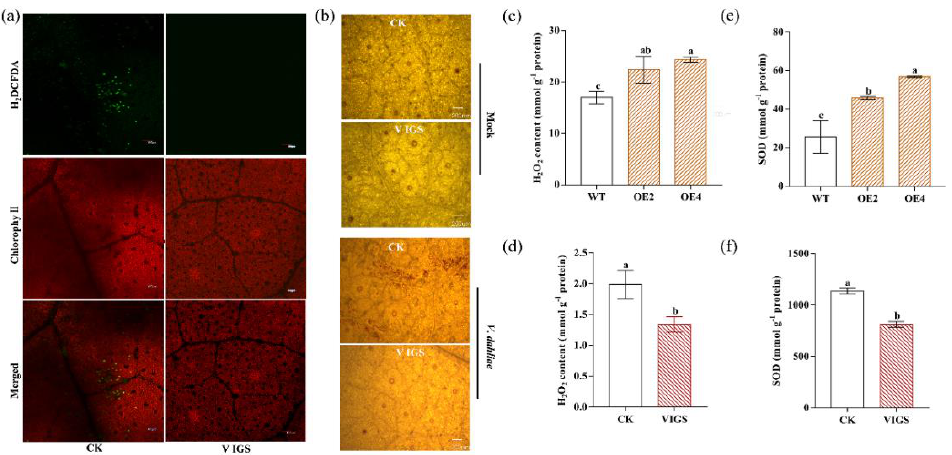
Figure 9. Determination of H 2 O 2 content and activities at 2 dpi. ( a ) Detection of ROS levels in cotton leaves by H 2 DCFDA staining. Then 10 mM H 2 DCFDA ROS—specific fluorescent indicator was used for the staining. Bars = 100 um. ( b ) H 2 O 2 visualization in cotton leaves by staining with DAB, showing more H 2 O 2 was produced in the TRV . 00 than the silent plants. Bars = 200 um. ( c – f ) Measurements of the contents of H 2 O 2 and SOD in cotton and Arabidopsis leaves at 2 dpi. Values are means with SD ( n = 3 biological replicates). Error bars represent the SD of three biological replicates. Lowercase letters represent statistically significant differences ( p < 0.05) according to Tukey’s HSD test.